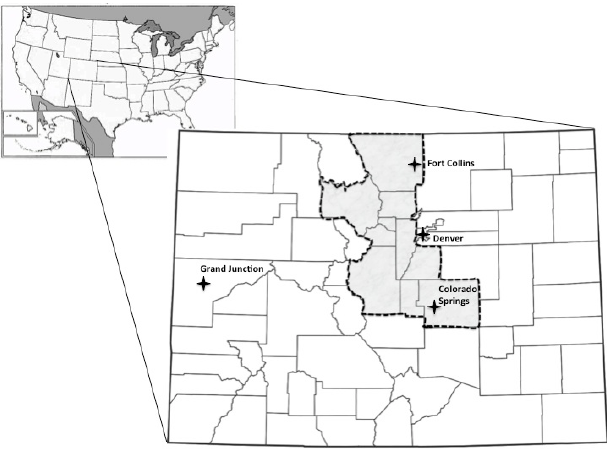
Fig. 1. Vicinity map of the Front Range Roundtable geographic area, encompassing 10 counties in Colorado,